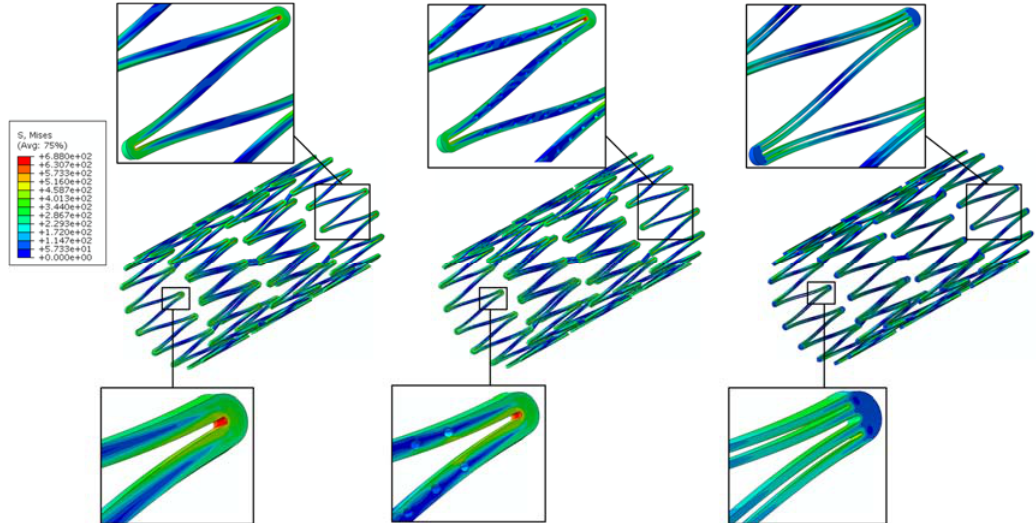
Figure 9. FEA contour plot comparison of von Mises stress distribution at 7.0 mm after release to a blood vessel among the conventional DES stent ( left ), conventional depot stent ( middle ), and rhombic ‐ shaped channel stent ( right , reservoir length 100% of the strut length).